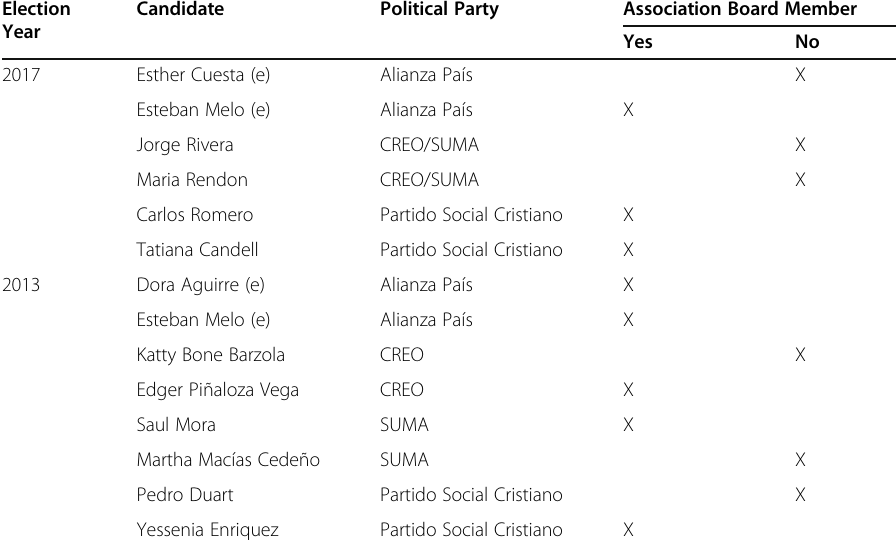
Sources: Interviews and candidates ’ webpages;